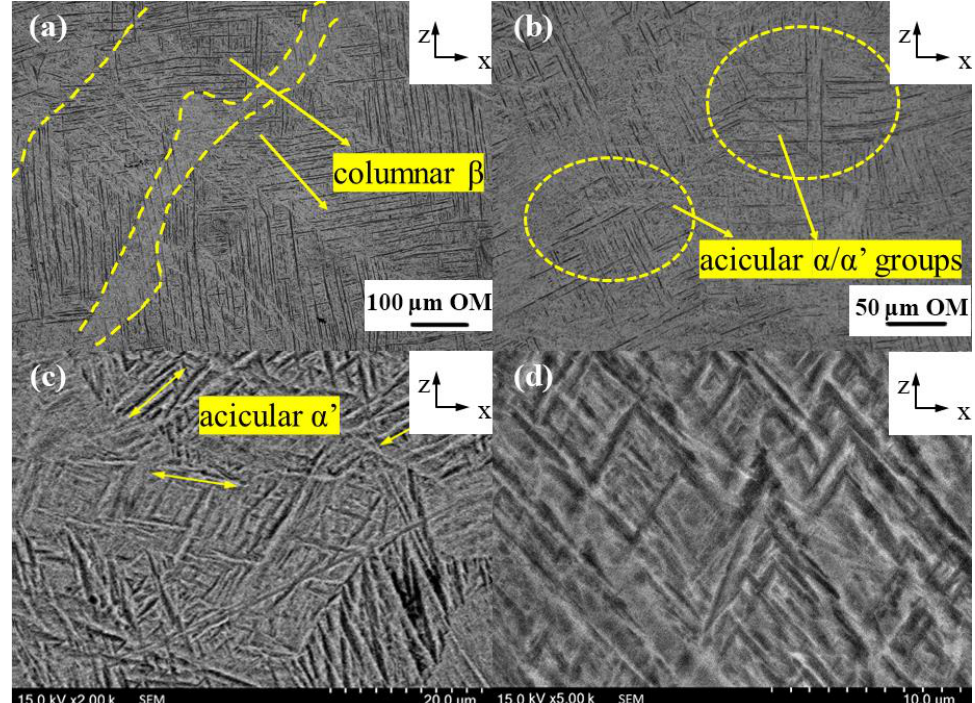
Figure 4. The microstructure of as-built SLM TC4: ( a ) OM-10×; ( b ) OM-20×; ( c ) SEM-2000×; ( d ) SEM-5000×.